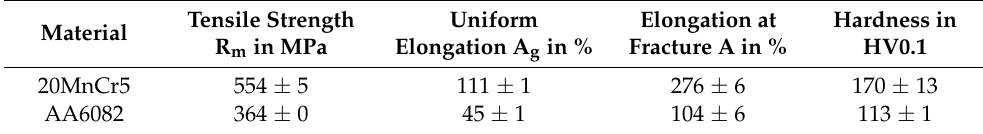
Table 1. Mechanical properties of the 20MnCr5 steel and AA6082 aluminum alloy.